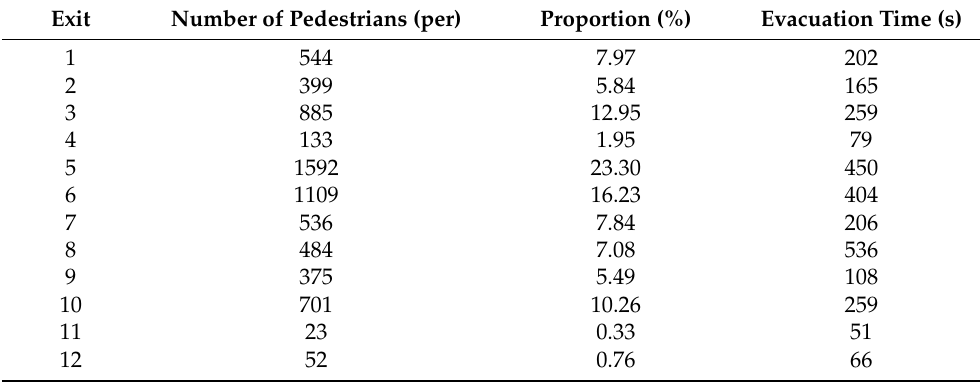
Table 6. Number of pedestrians evacuated and evacuation time at each exit of sample 28.